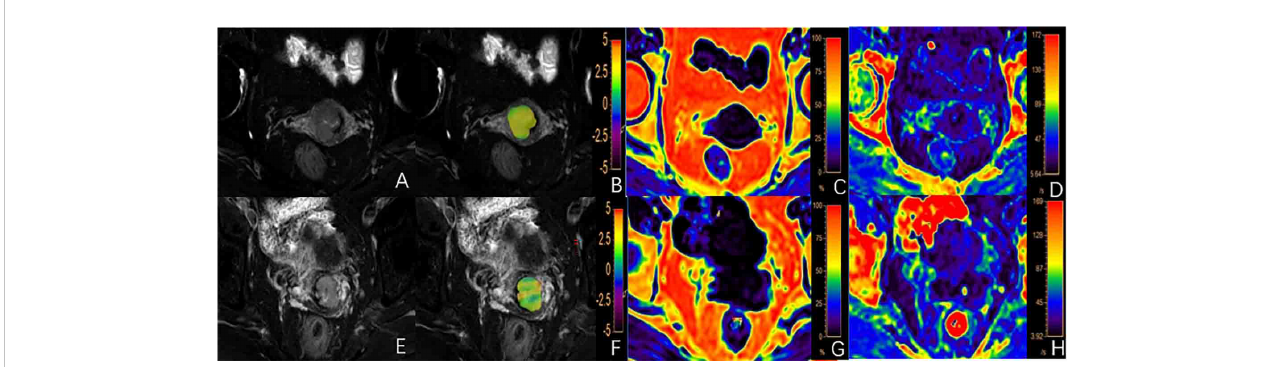
FIGURE 1 (A-D) A 62-year-old patient with a poorly differentiated cervical squamous carcinoma (CSC): (A) T 2 WI image, (B) fused APTw and T 2 WI image with the APTw value for the lesion of 2.45%; (C, D) FF and R (cid:1) 2 images with FF and R (cid:1) 2 values for the lesion of 2.69% and 19.62/s, respectively; (E-H) A 56-year-old patient with well/moderately differentiated CSC: (E) T 2 WI image; (F) fused APTw and T 2 WI image with an APTw value for the lesion of 2.05%; (G, H) The FF and R (cid:1) 2 images with FF and R (cid:1) 2 values for the lesion of 1.04% and 19.51/s,